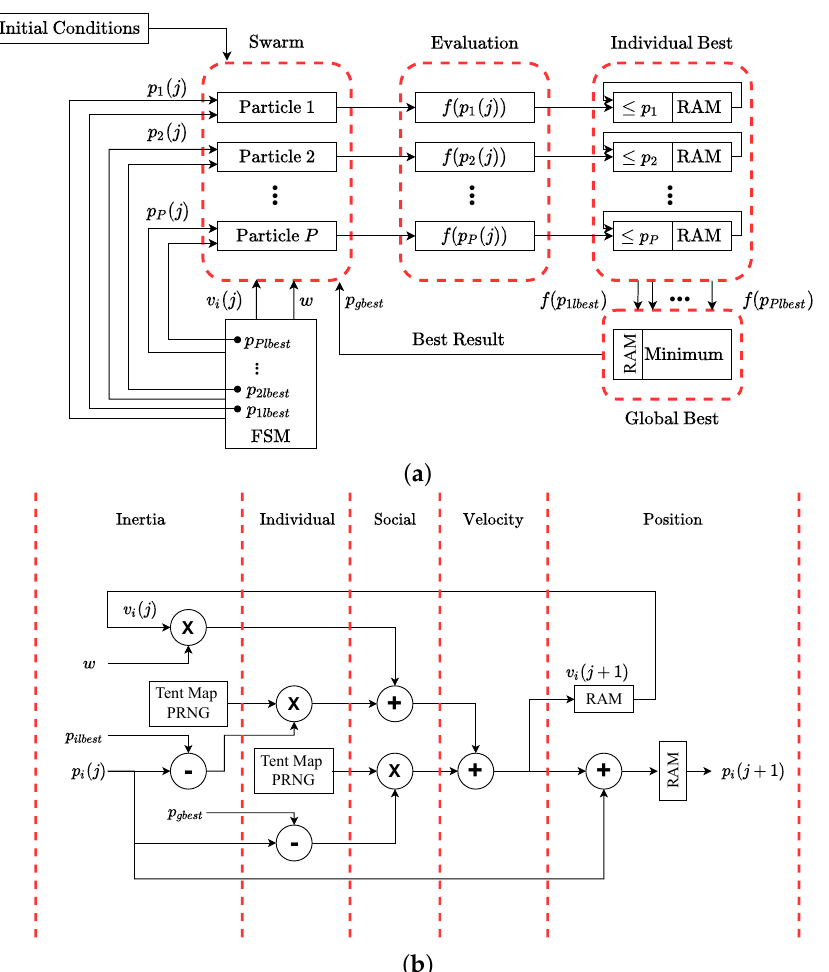
Figure 4. Implemented architecture. ( a ) Hardware architecture for particle swarm optimization. ( b ) Particle architecture which uses our digital tent map. Adapted with permission from ref. [25]. 2023,